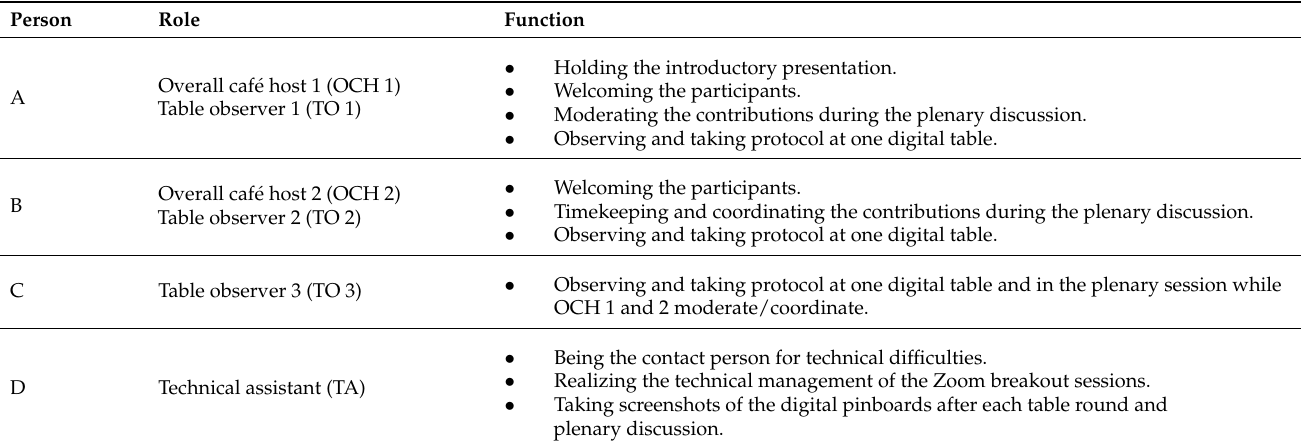
Table 1. Overview of the person involved in the hosting team, their roles, and